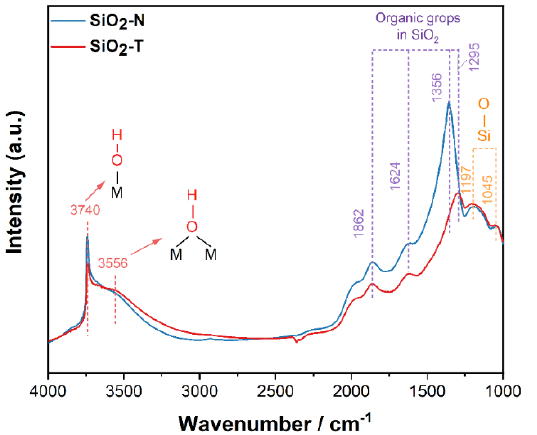
Figure 1. FTIR spectra of surface species on SiO 2 before and after piranha solution treatment.